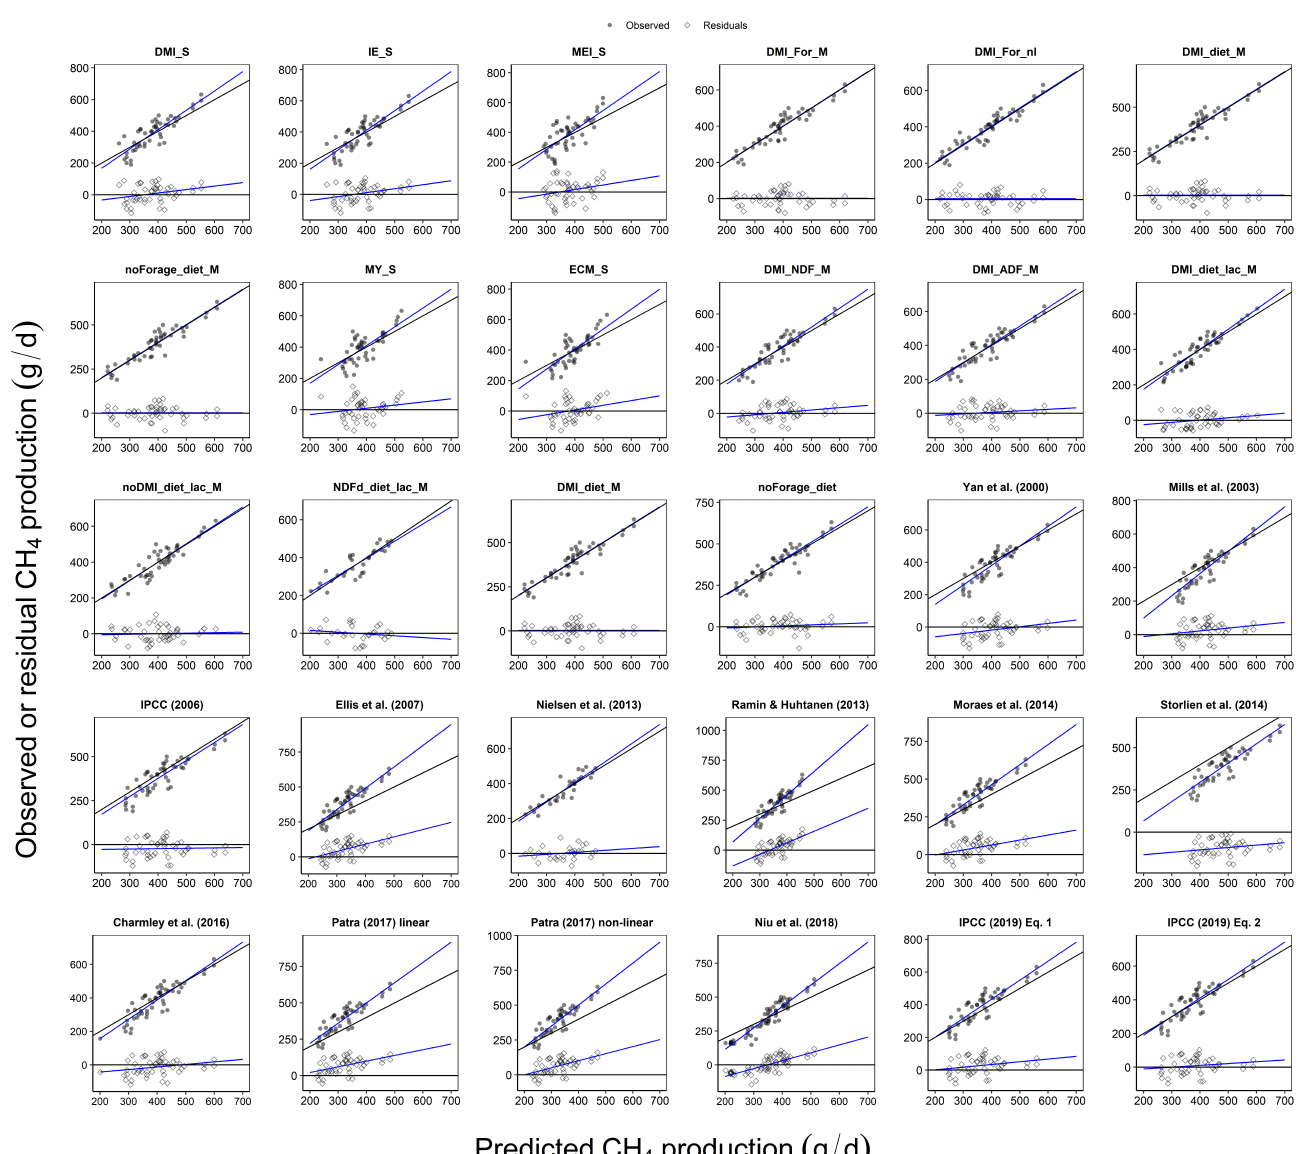
Figure 2. Plots of observed vs. predicted methane (CH 4 ) production (g/d) (illustrated by circles), and residuals (diamonds: observed—predicted values) vs. predicted methane production (g/d) (illustrated by diamond shapes) generated from the lactating cows (LAC) database ( n = 48) from different model categories and extant equations presented in accordance with Tables 3 and 4. The references interpretations are stated in Table 4. The solid blue lines indicate the relationship between predicted and observed methane production, and predicted values and the residuals. The solid black lines represent the line of unity, where y = x (1:1)